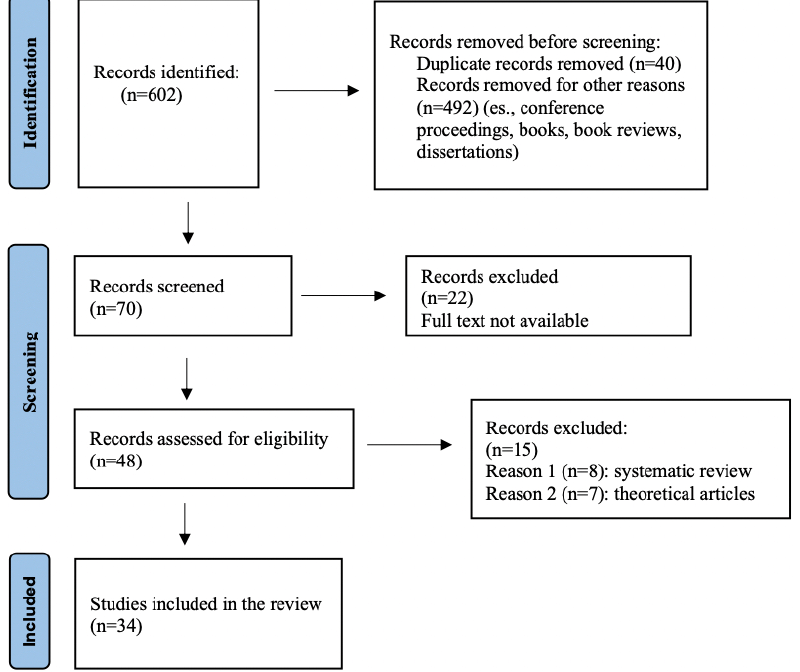
Figure 2. PRISMA flow diagram of the study selection process.